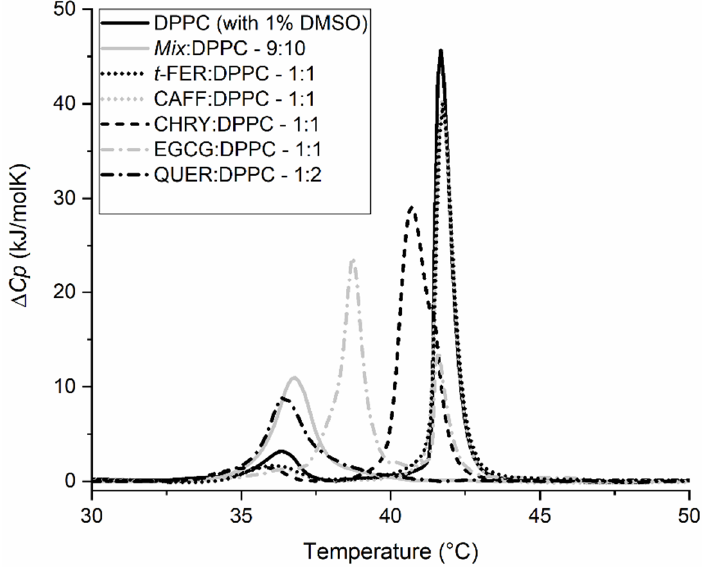
Figure 6. DSC thermograms of 1,2-dipalmitoyl- sn -glycero-3-phosphatidylcholine (DPPC) liposomes in 20 mM HEPES (pH = 7.0) buffer and 1% dimethyl sulfoxide (DMSO) (DPPC (with 1% DMSO); negative control), chrysin (CHRY), caffeic acid (CAFF), trans -ferulic acid ( t -FER), quercetin (QUER) (all in 1% DMSO and HEPES), (-)-epigallocatechin-3-gallate (EGCG) (in HEPES), or their mixture ( Mix ) (in 1% DMSO and HEPES) at different n compound/ Mix : n DPPC molar ratios. The molar ratios of the individual compounds for the n Mix : n DPPC = 9:10 molar ratio was n CHRY : n CAFF : n t -FER : n QUER : n EGCG : n DPPC = 2:2:2:1:2:10. ∆ C p is the change in heat